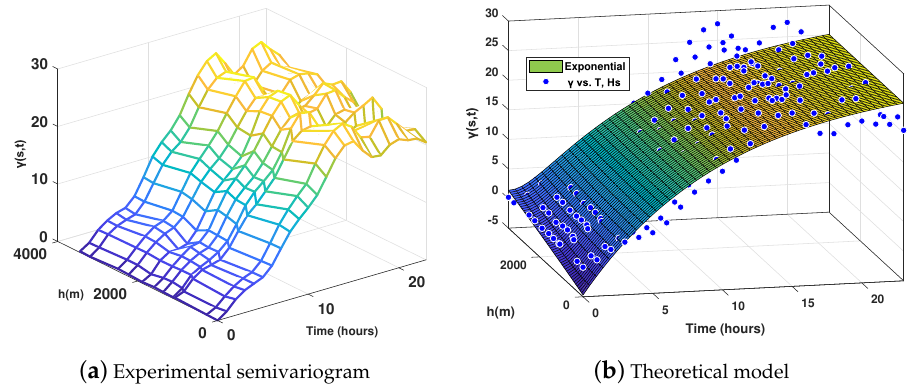
Figure 4. Experimental semivariogram and theoretical model of spatio-temporal data. ( a ) depicts the semivariogram obtained from spatio-temporal data. ( b ) depicts the fit of the experimental semivariogram to the theoretical